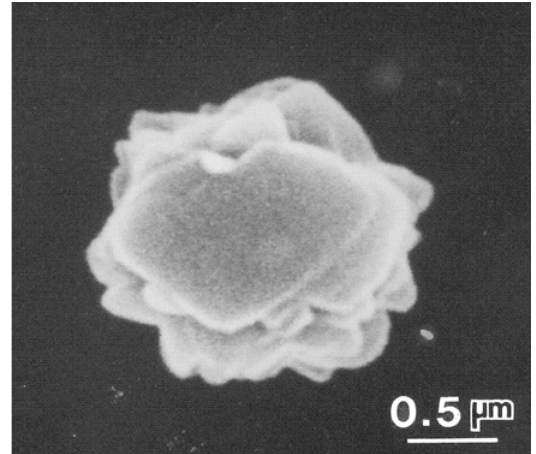
Figure 10. Scanning electron microscopy (SEM) micrograph showing that the final stage of crystal growth is composed of plate stacking, resulting in a star